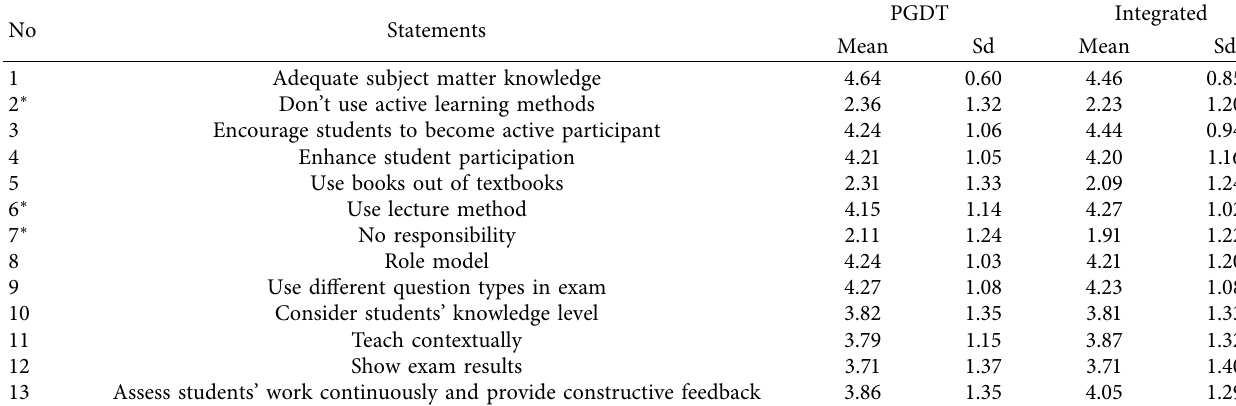
Table 1: Mean score of students’ perceptions on teaching effectiveness of PGDT and integrated curriculum. No